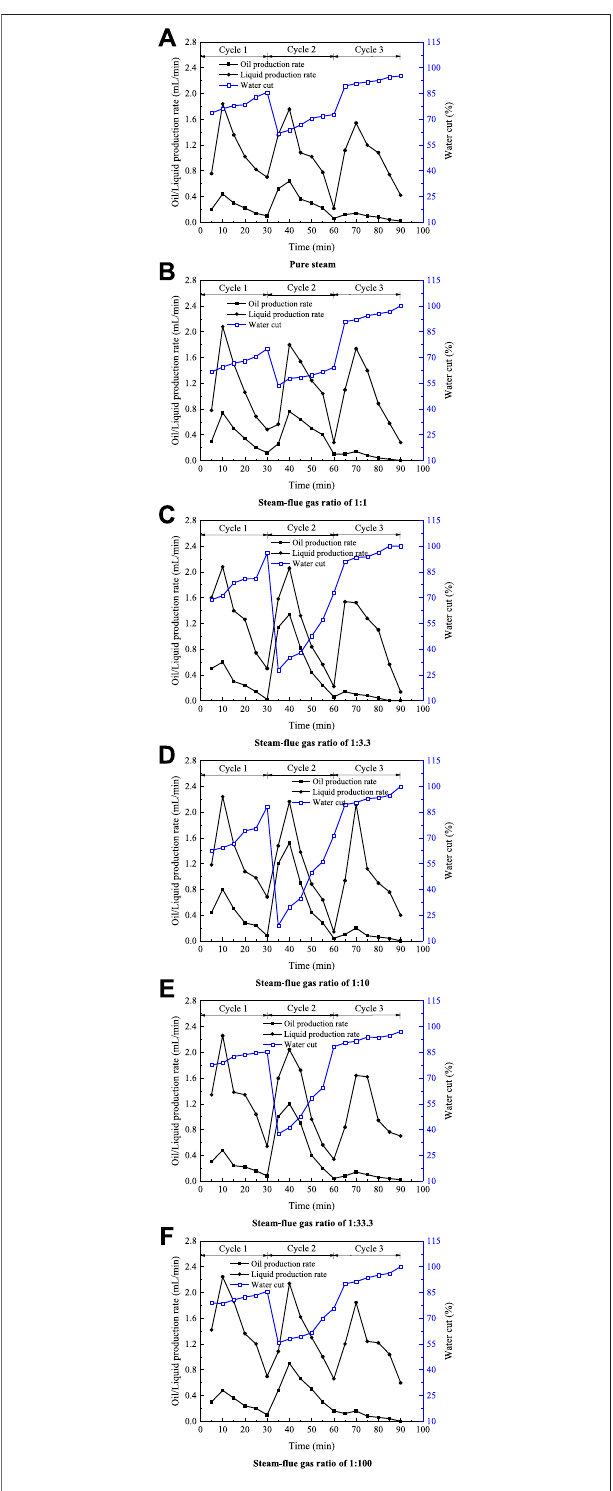
FIGURE 5 | Changes in oil production rate, liquid production rate and water cut with time. (A) Pure steam. (B) Steam- fl ue gas ratio of 1:1. (C) Steam- fl ue gas ratio of 1:3.3. (D) Steam- fl ue gas ratio of 1:10. (E) Steam- fl ue gas ratio of 1:33.3. (F) Steam- fl ue gas ratio of